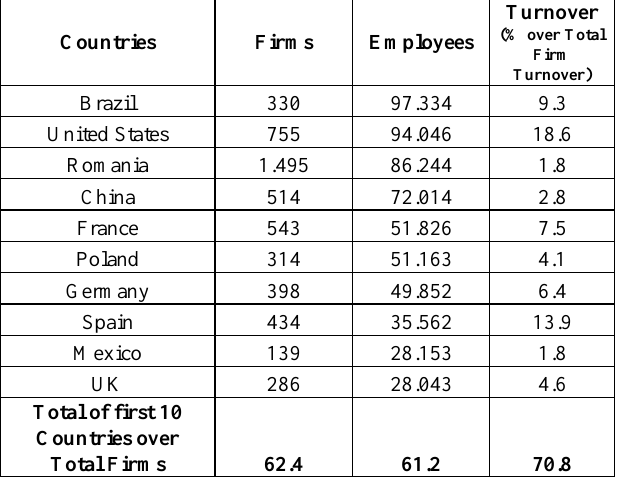
Table 3: Location of Italian Companies Abroad in 2011. Top Ten Countries. Industry Countries Firms